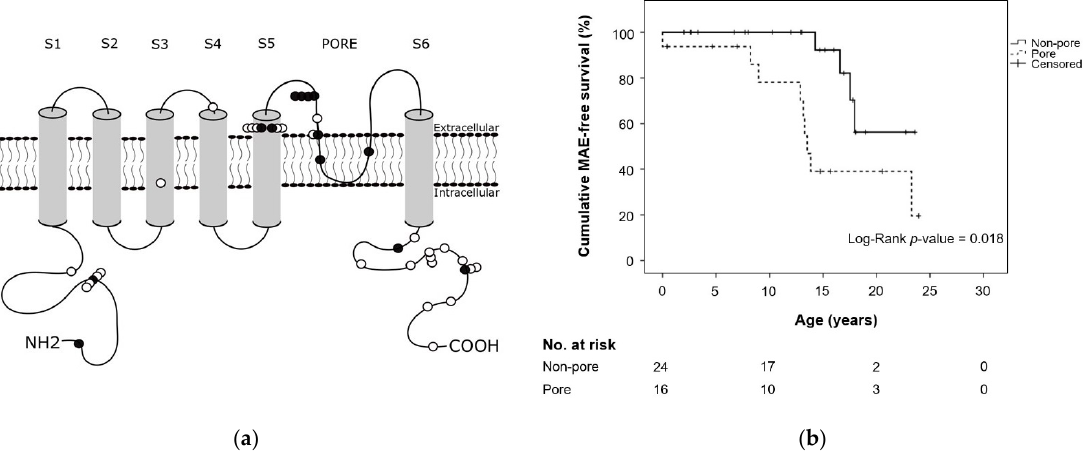
Figure 1. ( a ) Distribution of variants in the KCNH2 potassium channel, depending on major arrhythmic event (MAE). Black dot: occurrence of MAE; white dot: without occurrence of MAE. ( b ) Kaplan–Meier estimates of survival without major arrhythmic event (MAE) among the 40 LQTS2 patients, depending on location of variant. Pore: S5 ‐ loop ‐ S6 region. Non ‐ pore: N ‐ term, S1–S4 region, or C ‐ term.